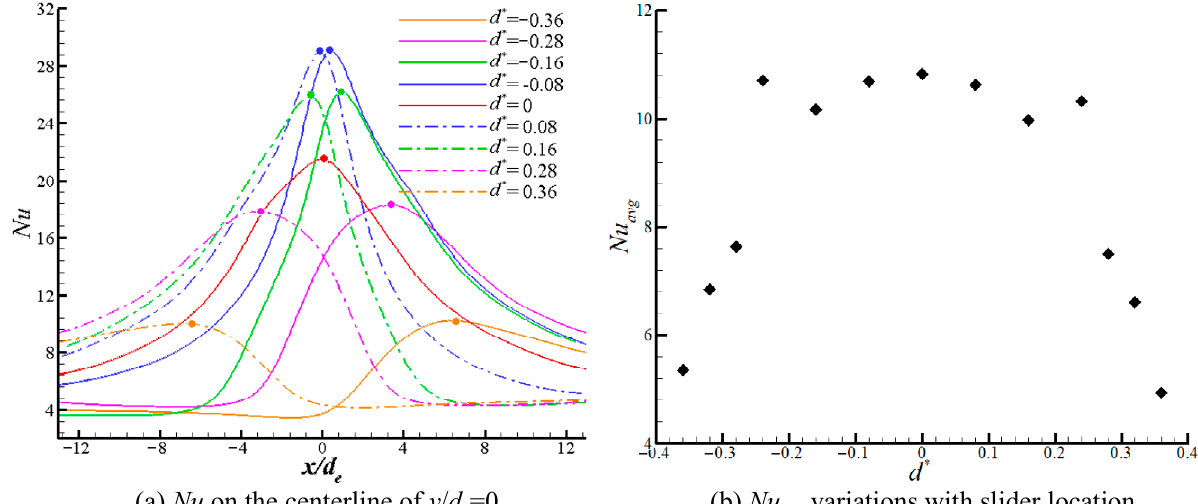
Figure 4. Variations of Nu and Nu avg .